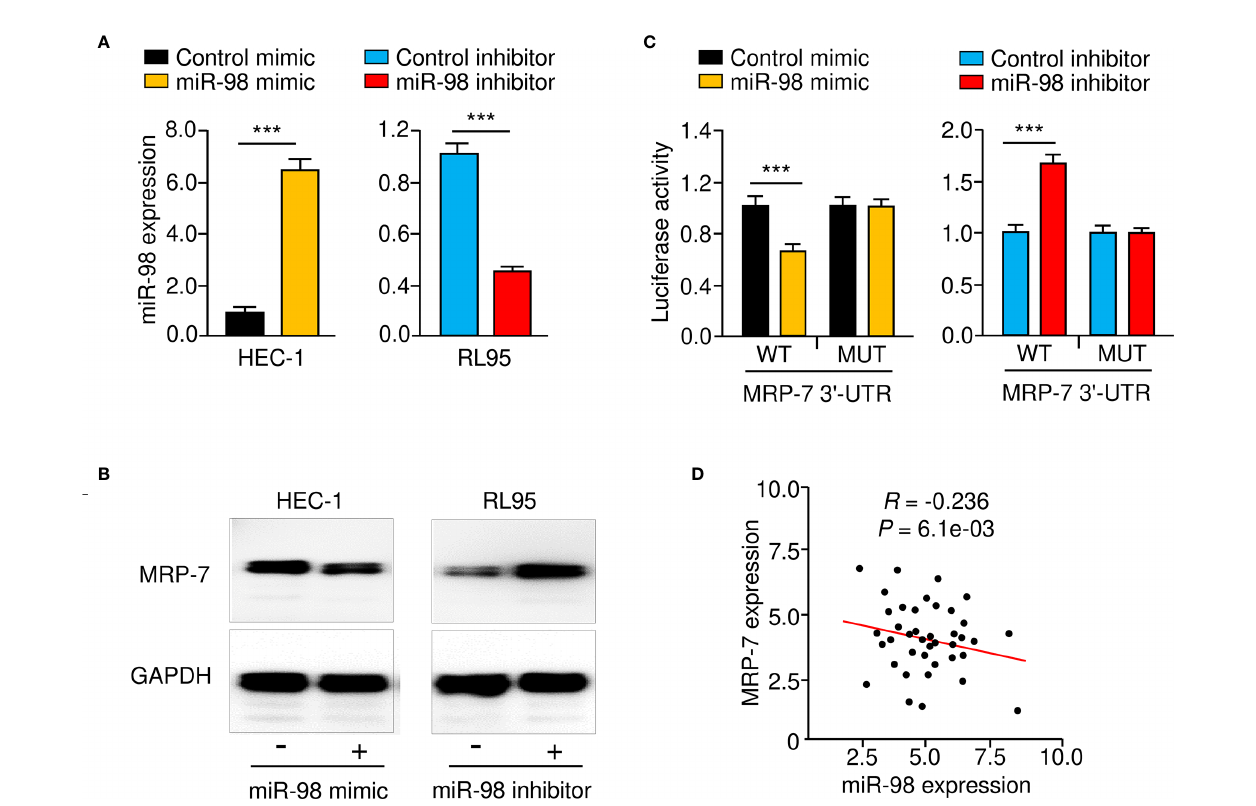
FIGURE 6 | MRP-7 is a Downstream Target of MiR-98. (A) The expression of miR-98 in EC cells transfected with miR-98 mimic, miR-98 inhibitor, or their controls. (B) MRP-7 expression in EC cells transfected as indicated as determined by Western blotting. (C) The luciferase activity of reporter vectors